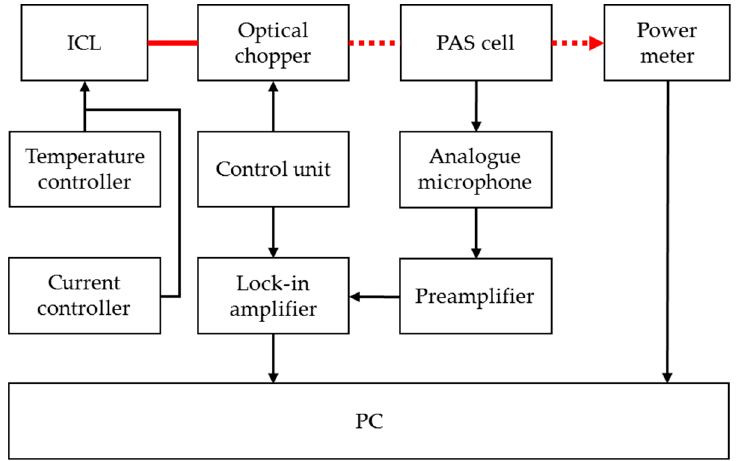
Figure 1. Experimental setup of the photoacoustic sensor